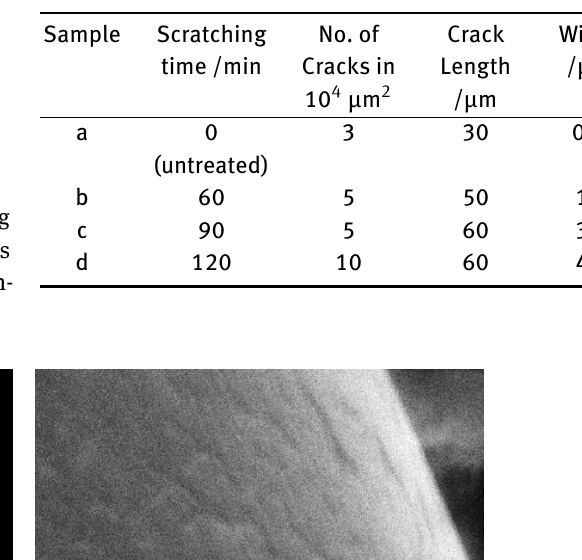
Table 1: Surface crack statistics on stainless steel 316L wires due to